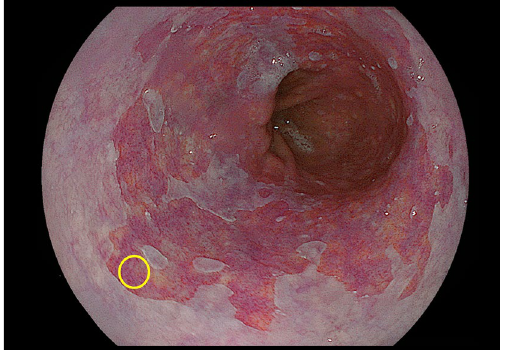
Figure 1. Representative case of targeted biopsy for nondysplastic Barrett’s esophagus (C4M6, long-segment Barrett’s esophagus case 8). Biopsy specimens were taken from the most elongated part of the Barrett’s esophagus to separate from the epithelium of the stomach. The yellow circle shows the area where the biopsy was taken.